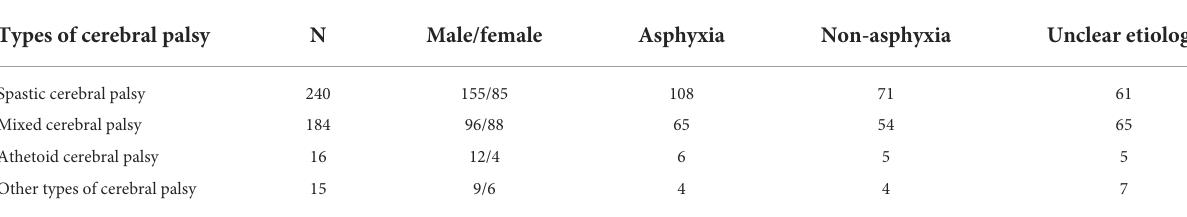
TABLE 2 Clinical data and statistics for cerebral